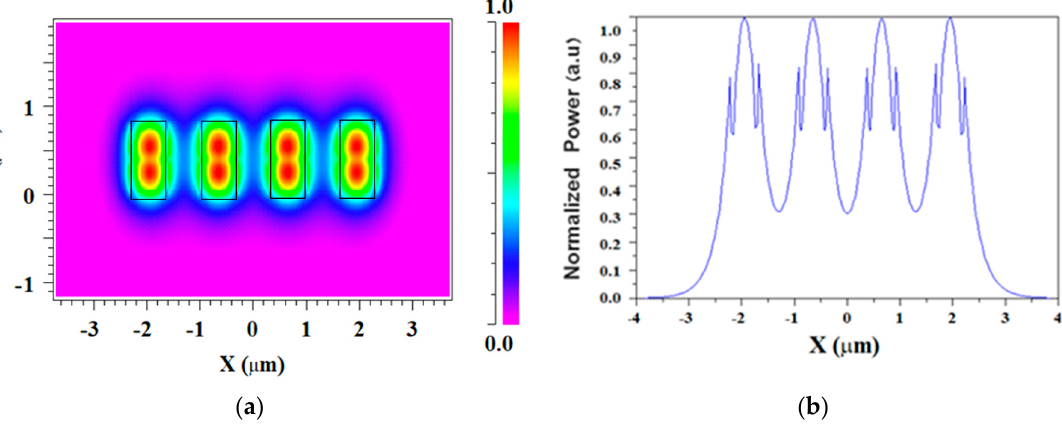
Figure 3. TE fundamental mode solution for four slot waveguide structures: ( a ) E y mode field pat- tern; ( b ) Horizontal cut at y = 175 nm. ( b ) Horizontal cut at y = 175 nm.